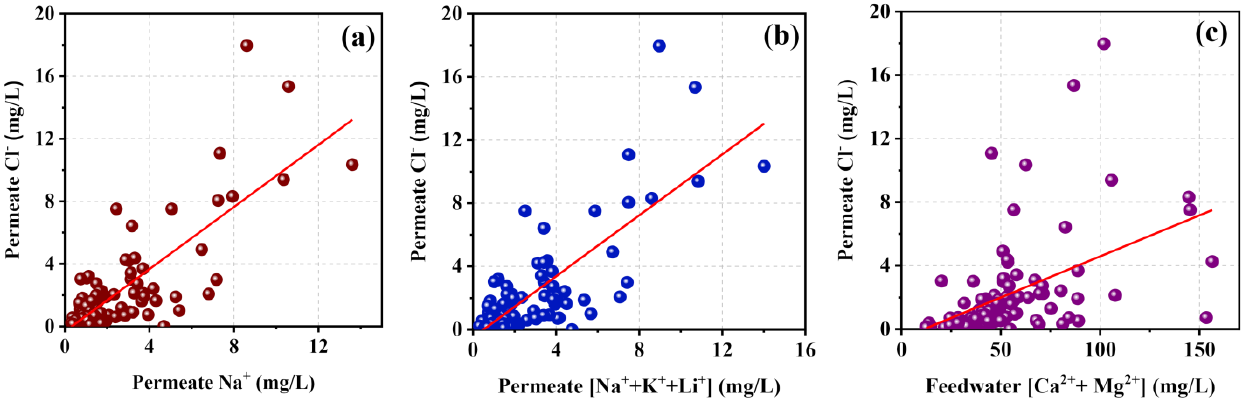
Figure 9. Chloride permeability through RO membranes with the concentration of ( a ) Na + in the permeate, ( b ) total monovalent cations in the permeate, and ( c ) divalent cations in the feedwater.